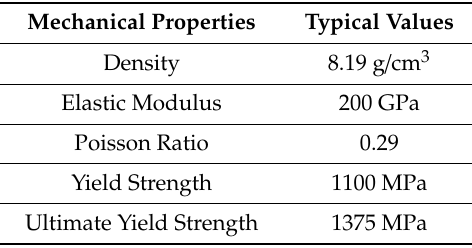
Table 3. Mechanical Properties of Inconel 718 (UNS